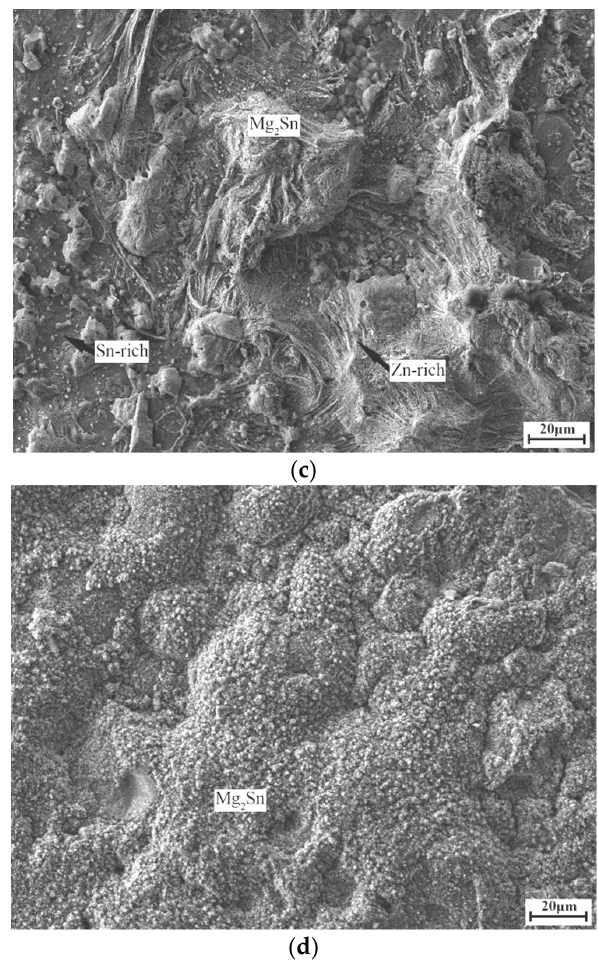
Figure 16. Fractographs of the AZ31 magnesium alloy/6061 aluminum alloy joints bonded with the Sn-30Zn-0.1RE filler metal after aging at 150 °C. ( a ) the 6061 aluminum alloy side after 50 h of aging; ( b ) the AZ31 magnesium alloy side after 50 h of aging; ( c ) the 6061 aluminum alloy side after 100 h of aging; ( d ) the AZ31 magnesium alloy side after 100 h of aging.